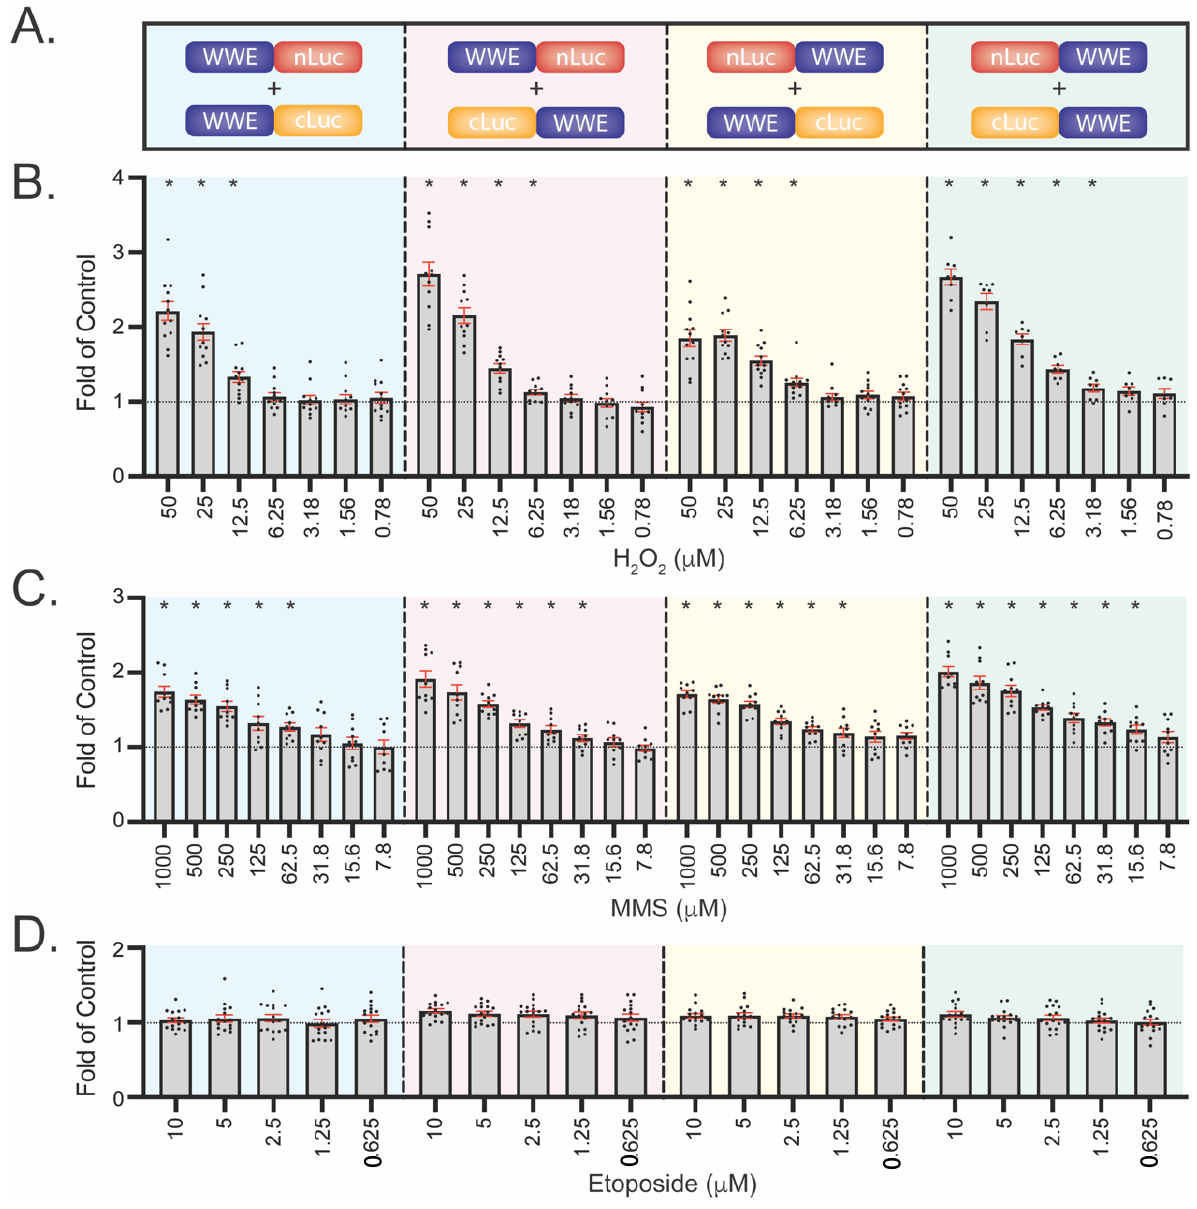
Figure 4. Development of WWE split luciferase (Luc) assay to measure PARylation. ( A ) Vector designs to assess the effect of WWE and split-Luc orientation. WWE was fused to either the N-terminal side of nLuc or cLuc, or to the C-terminal side of nLuc or cLuc. Four combinations were tested. ( B ) PAR formation following 30 min H 2 O 2 dose – response. Values are normalized to untreated or DMSO controls. ( C ) PAR formation following 30 min MMS dose – response. ( D ) PAR formation following 30 min etoposide dose – response. Each dot represents a single plate reading, with mean and SEM (red bars) shown; N ≥ 8 reads. * p < 0.05 using a one-sample t